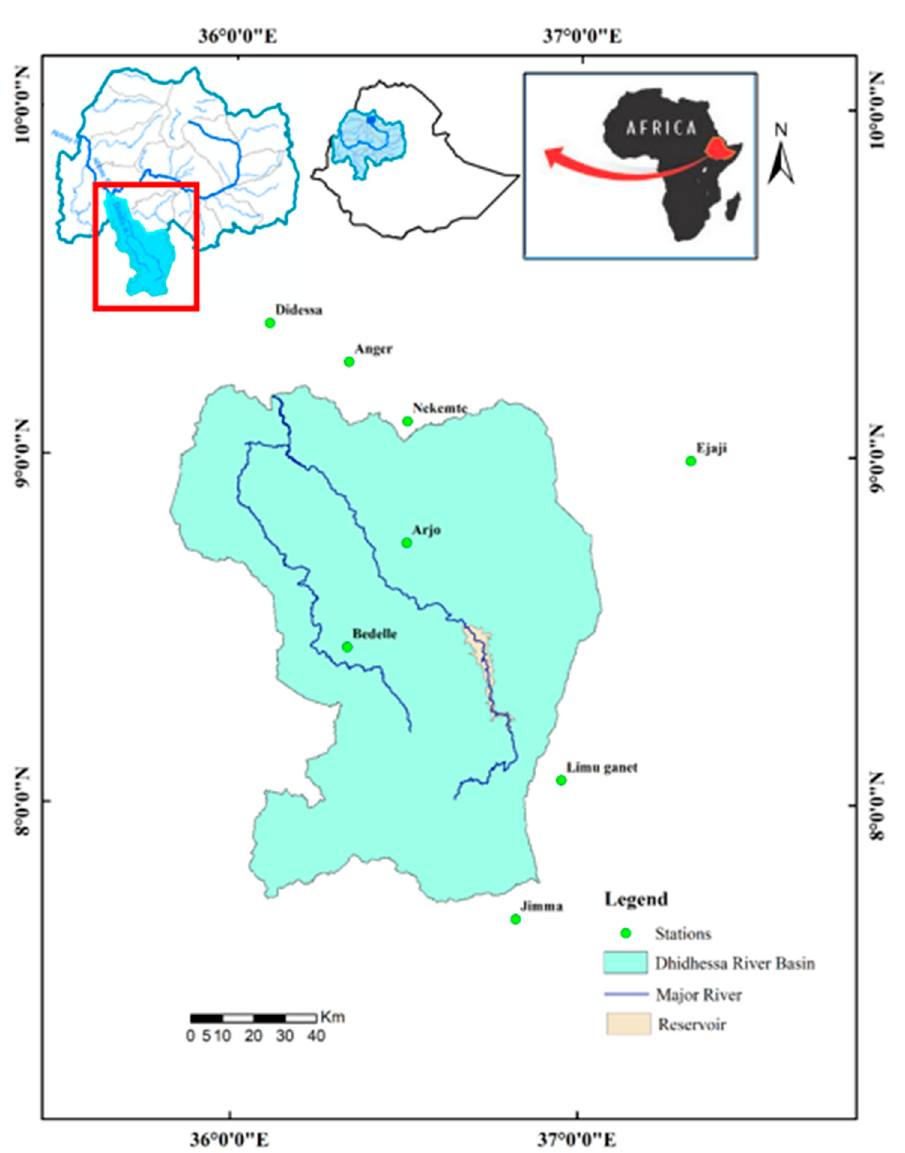
Figure 2. Distribution of meteorological station in and around the sub-basin.